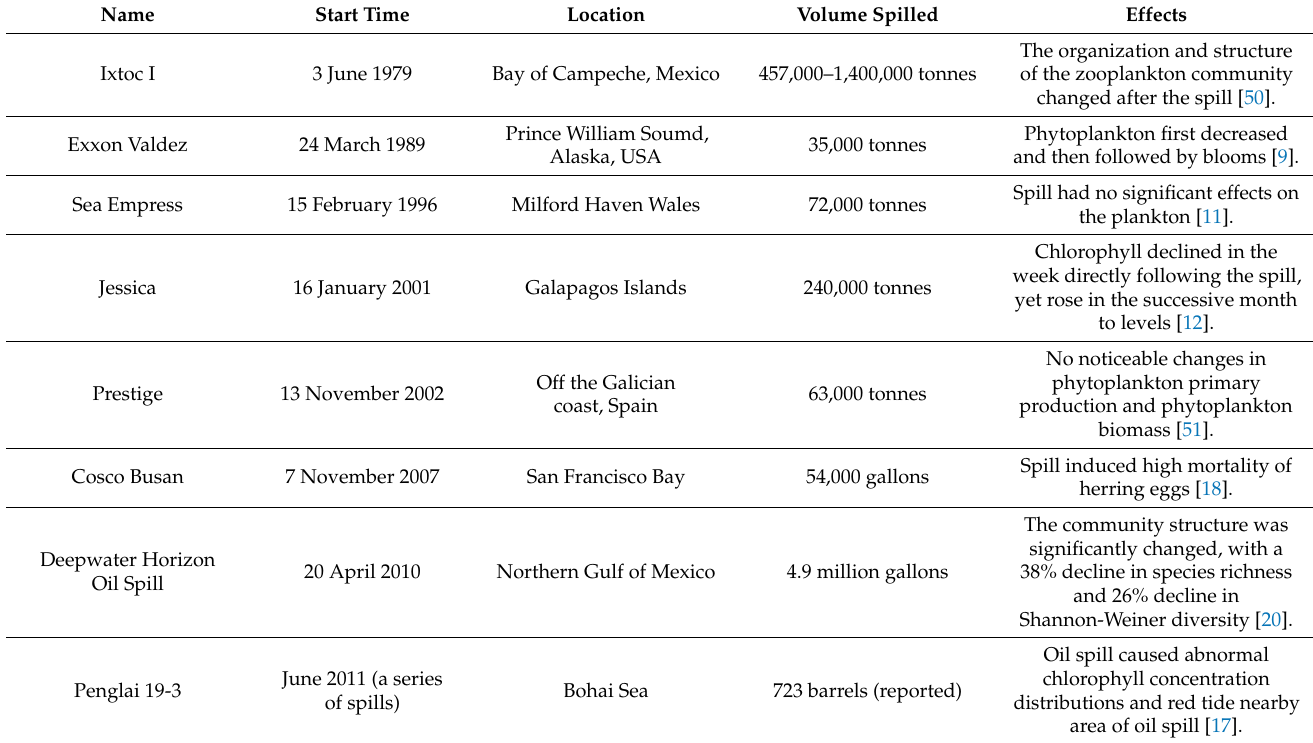
Table 2. Some marine oil spills reported and their implicit